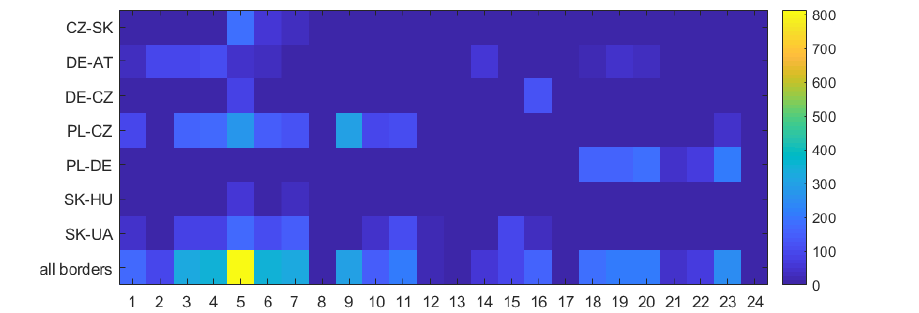
Figure 4. Overload [MW] identified on specified borders for 24 timestamps of reference